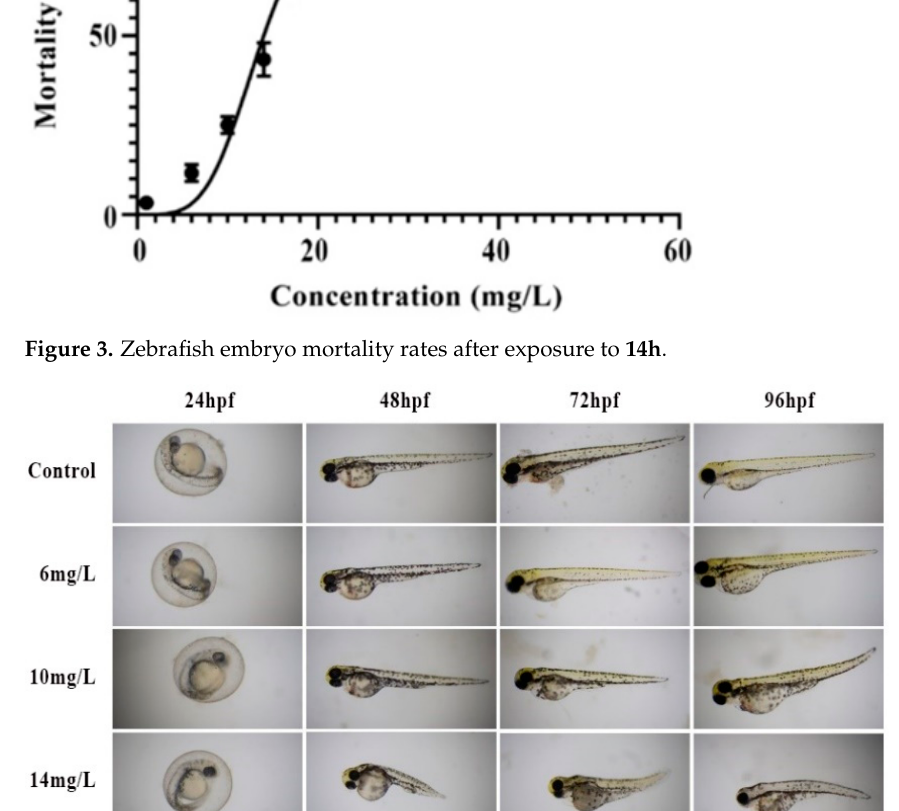
Figure 3. Zebrafish embryo mortality rates after exposure to 14h .